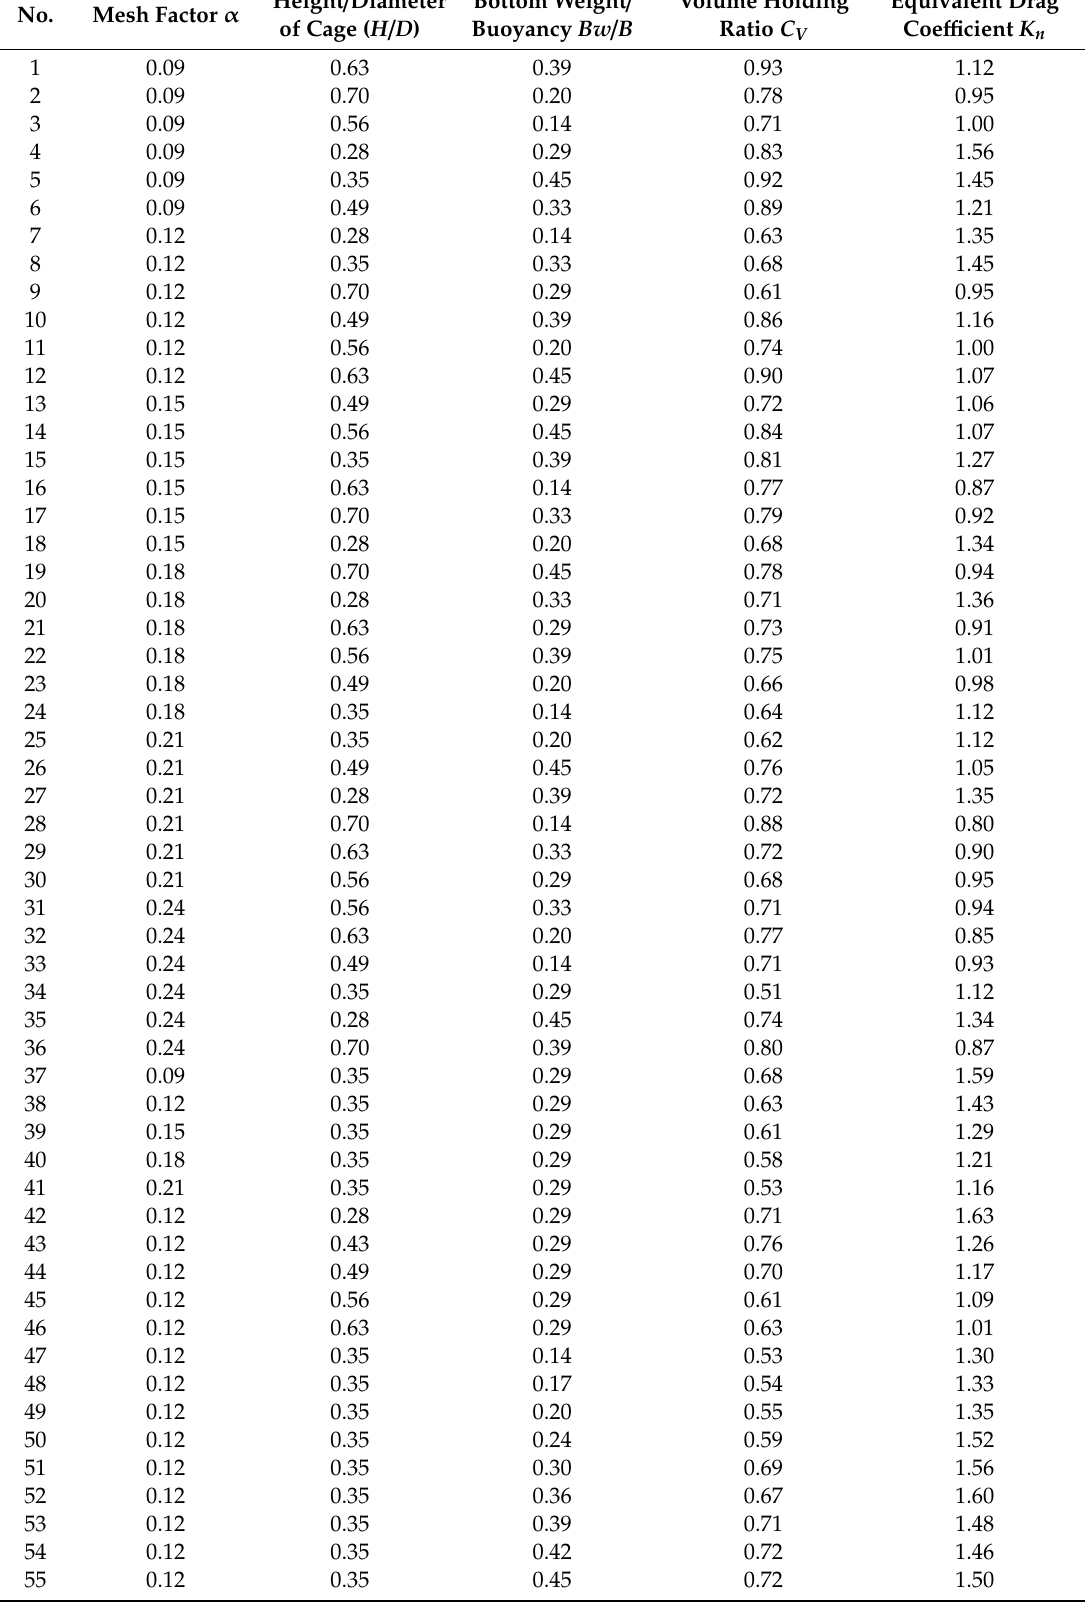
Table A1. Data used to train the neural